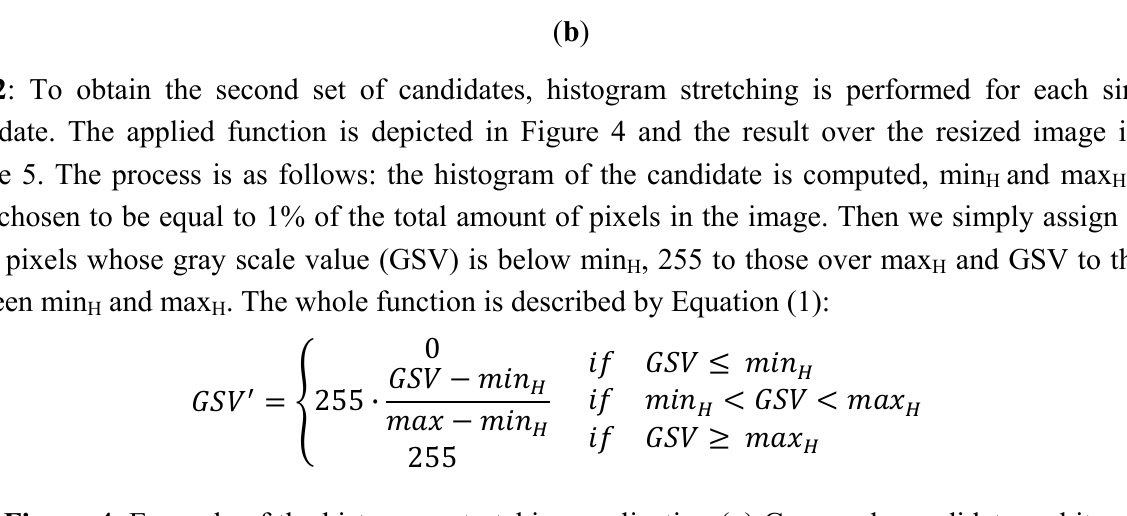
Figure 4. Example of the histogram stretching application ( a ) Gray scale candidate and its histogram. ( b ) Function applied to ( a ) by means of Equation (1). ( c ) Gray scale image and its histogram resulting from histogram